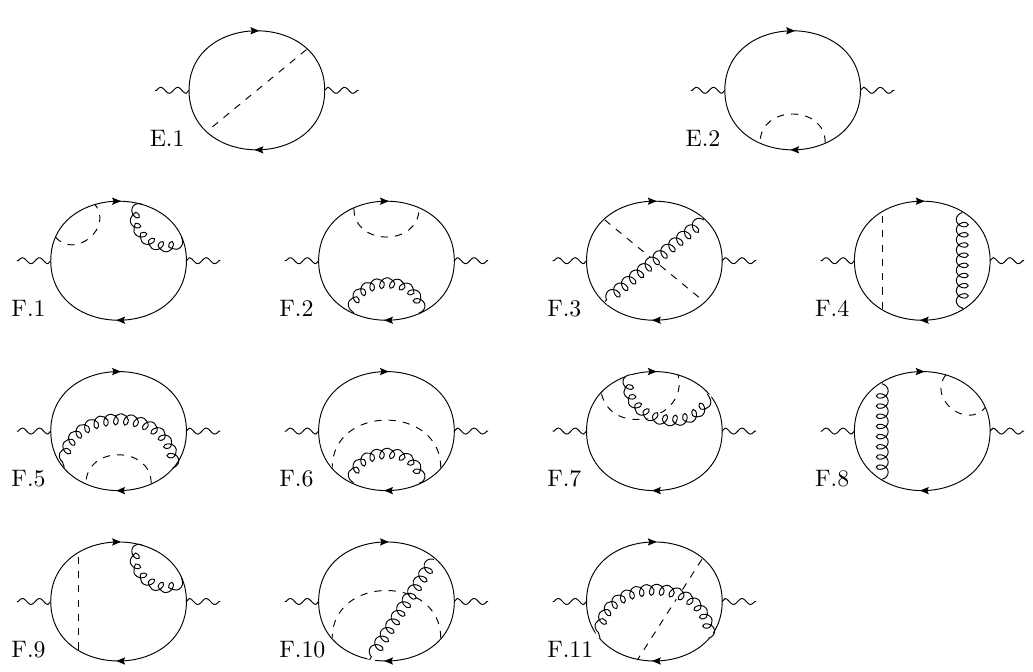
Figure 13. All contributing supergraphs to the class of processes e + e − → γ → t ¯ tH + X at LO (E.1) and NLO (F.i). The external current e + e − → γ is not shown. We note that we do not show the isomorphic partners F.1, F.4, F.7, F.8 and F.9 obtained by a mirror symmetry around the vertical central axis of the corresponding graph F.i (see explicit example with graphs D.7 and D.7 in table